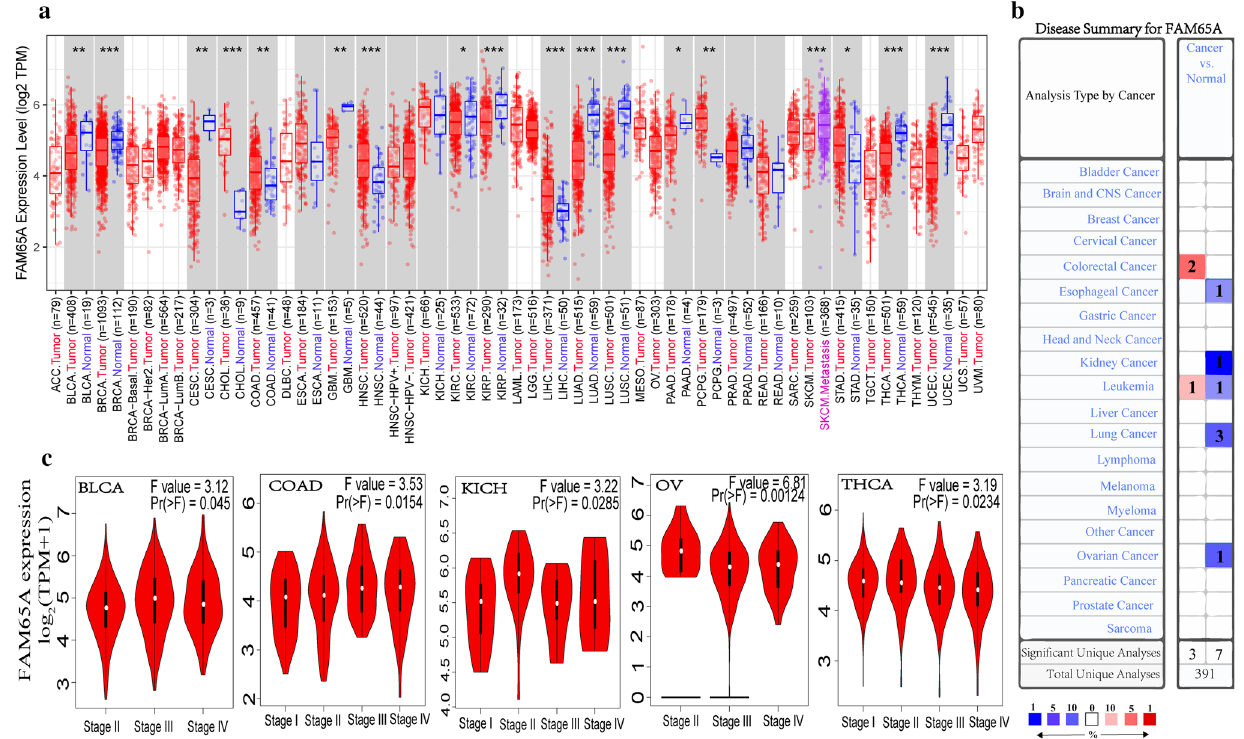
Fig. 1 The expression level of FAM65A gene in different tumors. a The expression levels of FAM65A in human tumors and corresponding normal tissues are obtained through the TIMER2. b The expression levels of FAM65A in human tumors and corresponding normal tissues are obtained through the oncomine. c The FAM65A expression violin plots in different pathological stages of BLCA, COAD, KICH, OV and THCA are obtained through the GEPIA2. *P < 0.05, **P < 0.01, ***P <